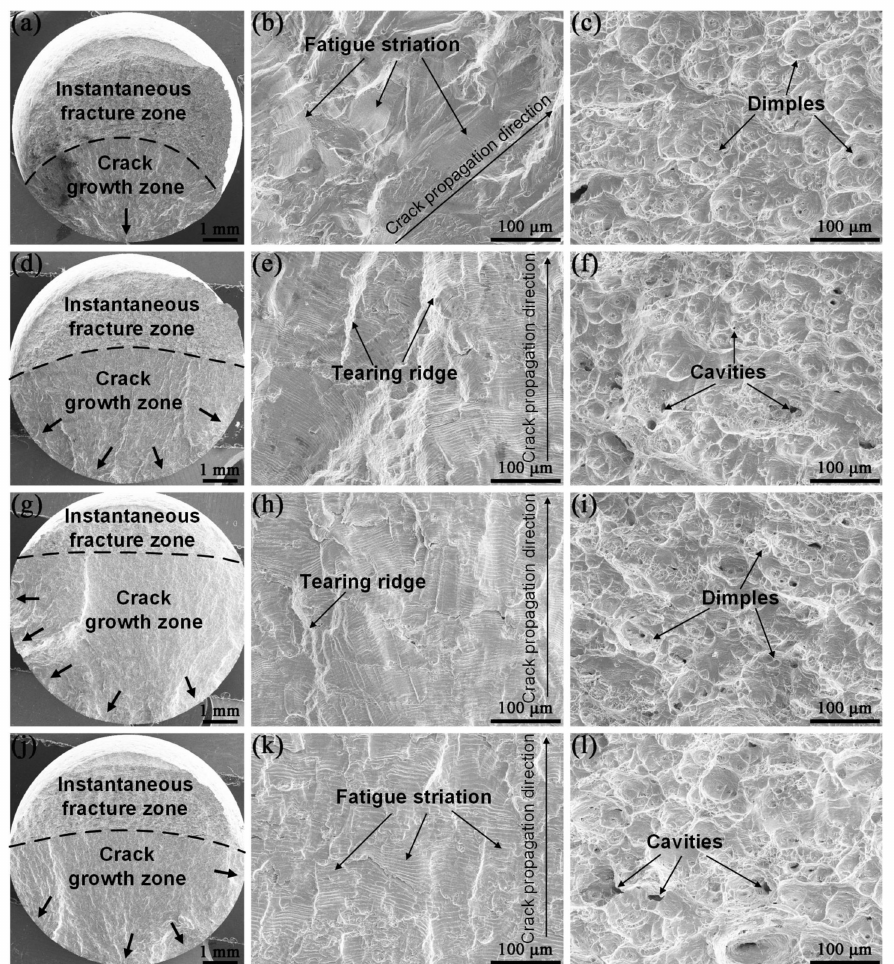
. ε = 2 × 10 − 3 s − 1 ; . ε = 3.2 × 10 − 4 s − 1 ; ( j – l )